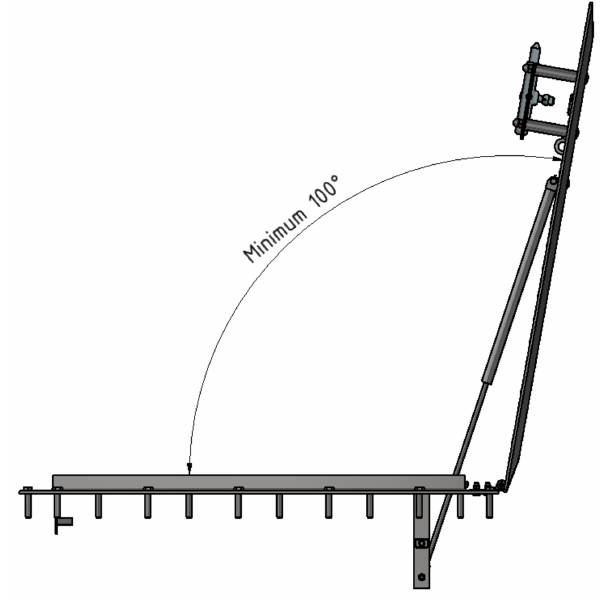
Figure 6. Hatch opening angle according to ˇCSN EN 124.